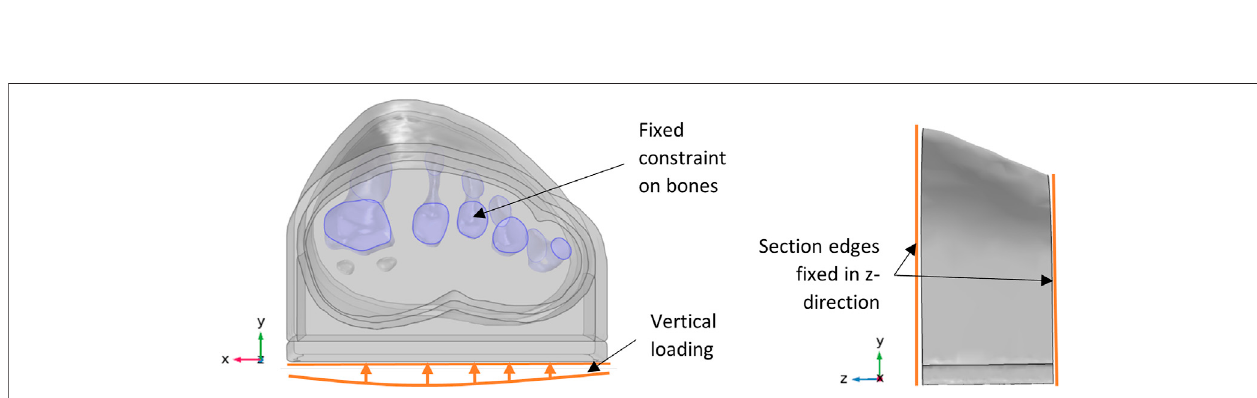
FIGURE 2 | P3 model, indicating vertical loading and boundary conditions.